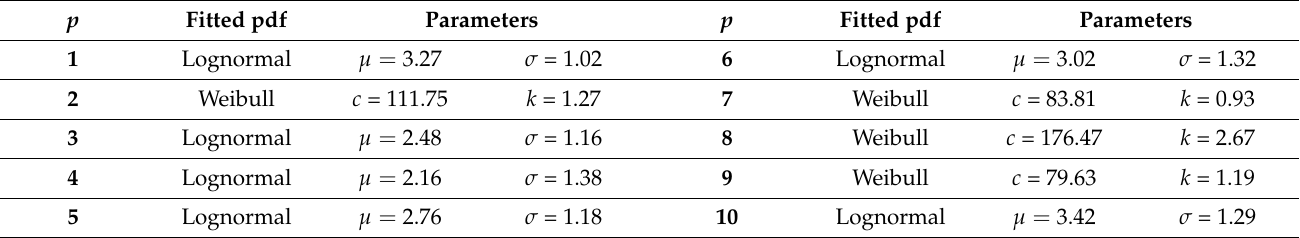
Table 2. Fitted PDFs parameters for different